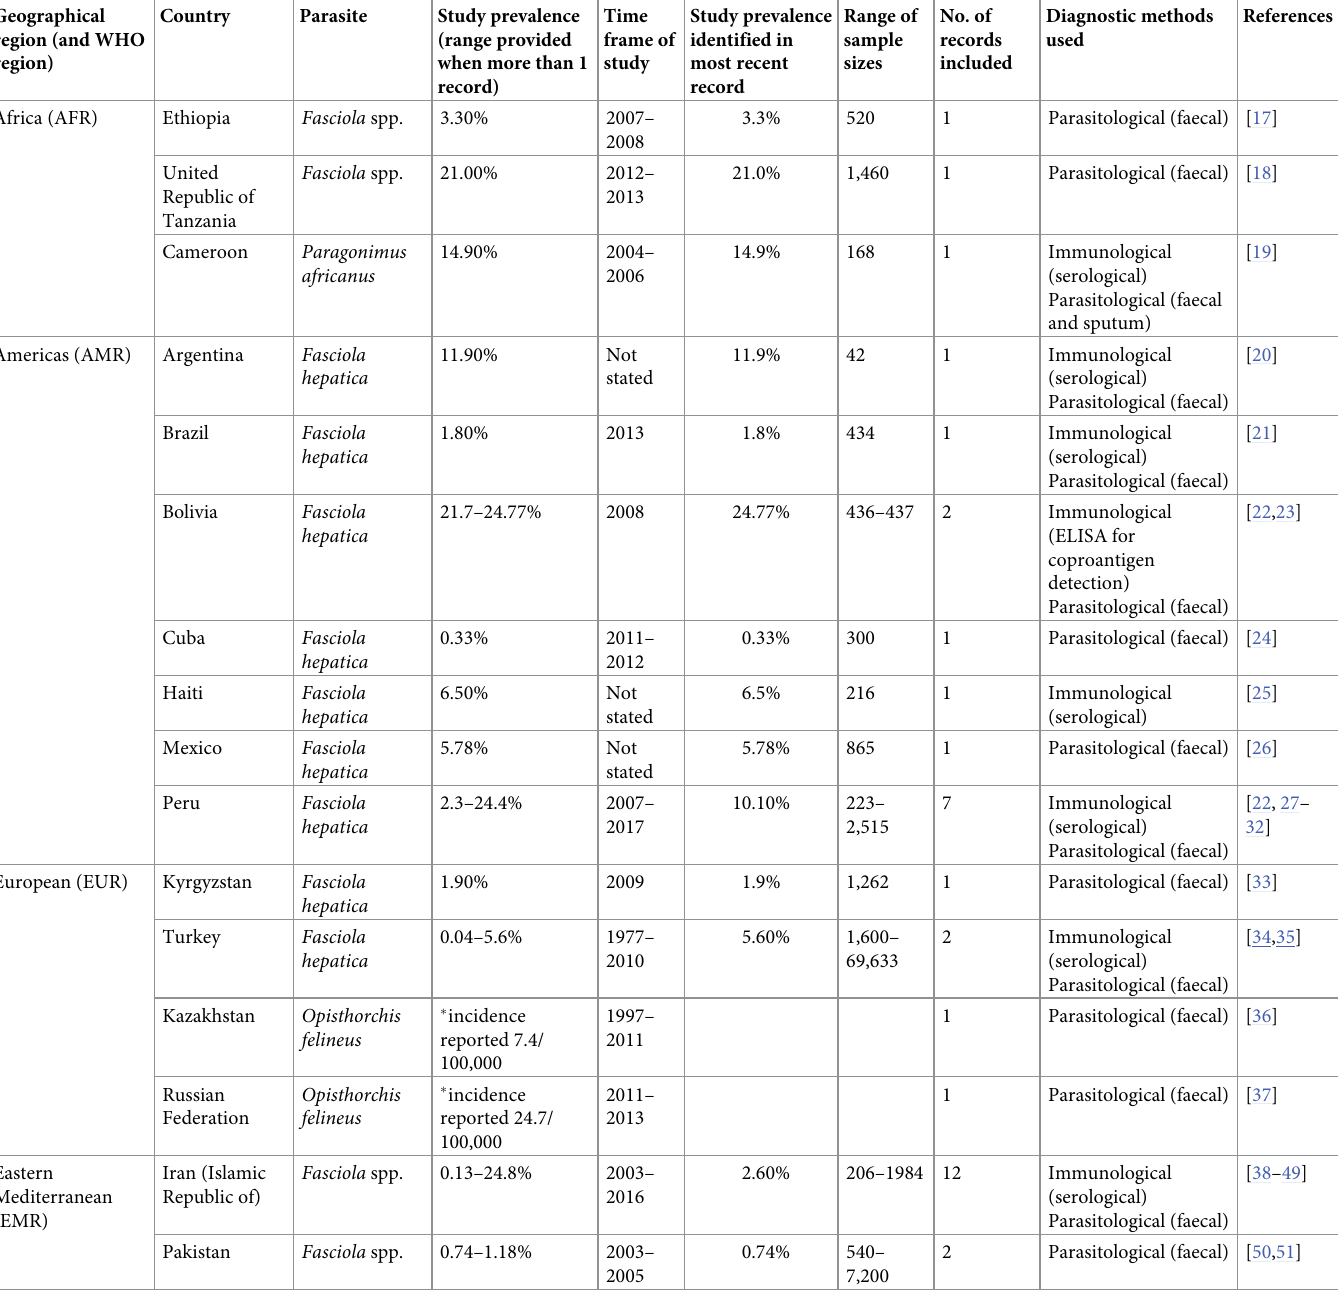
Table 1. Study prevalence range of FBTs recorded in the literature from 2010–2020, presented by country and parasite. Geographical region (and